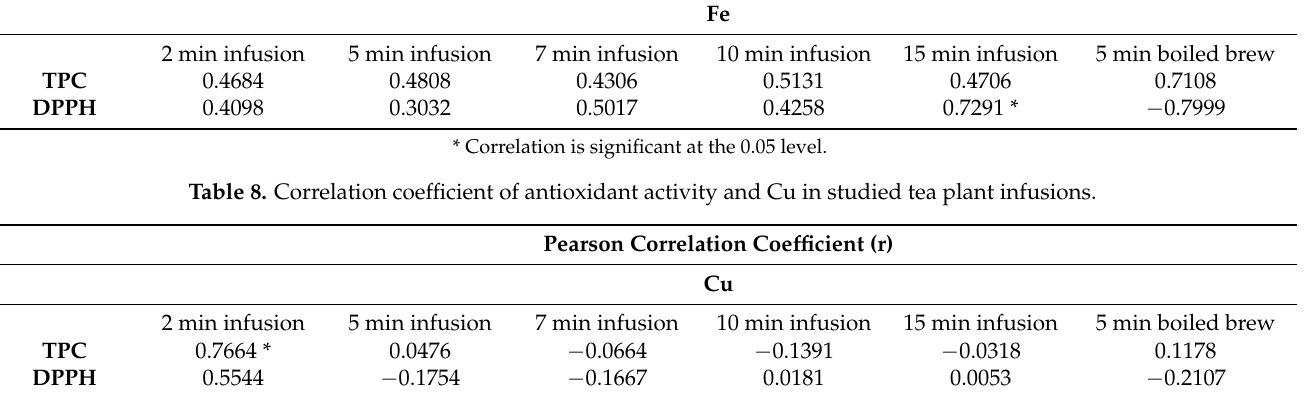
Table 7. Correlation coefficient of antioxidant activity and Fe in studied tea plant infusions. Pearson Correlation Coefficient (r) Fe